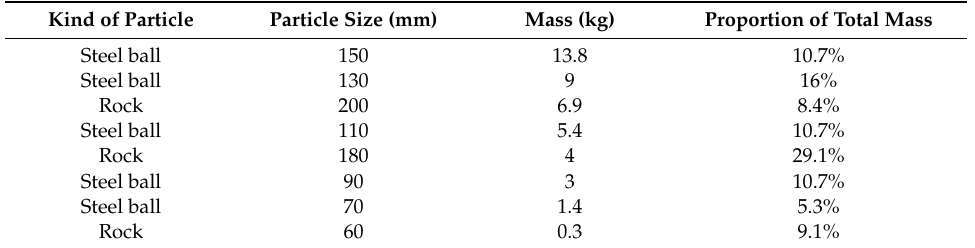
Table 2. Each kind of particle mass and the proportion of these particle masses to the total mass.